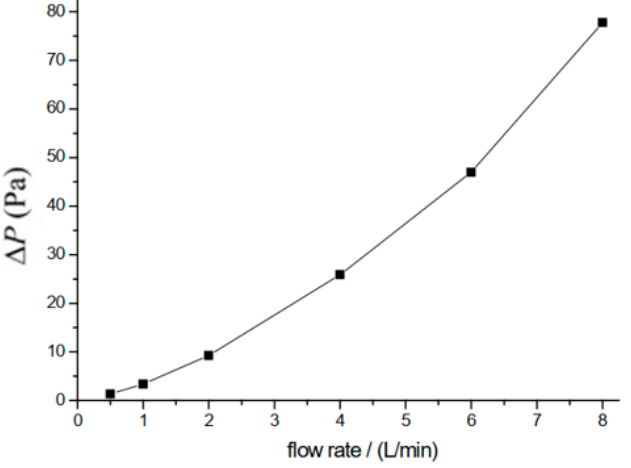
Figure 10. Effects of coolant flow rates on pressure drops [57].